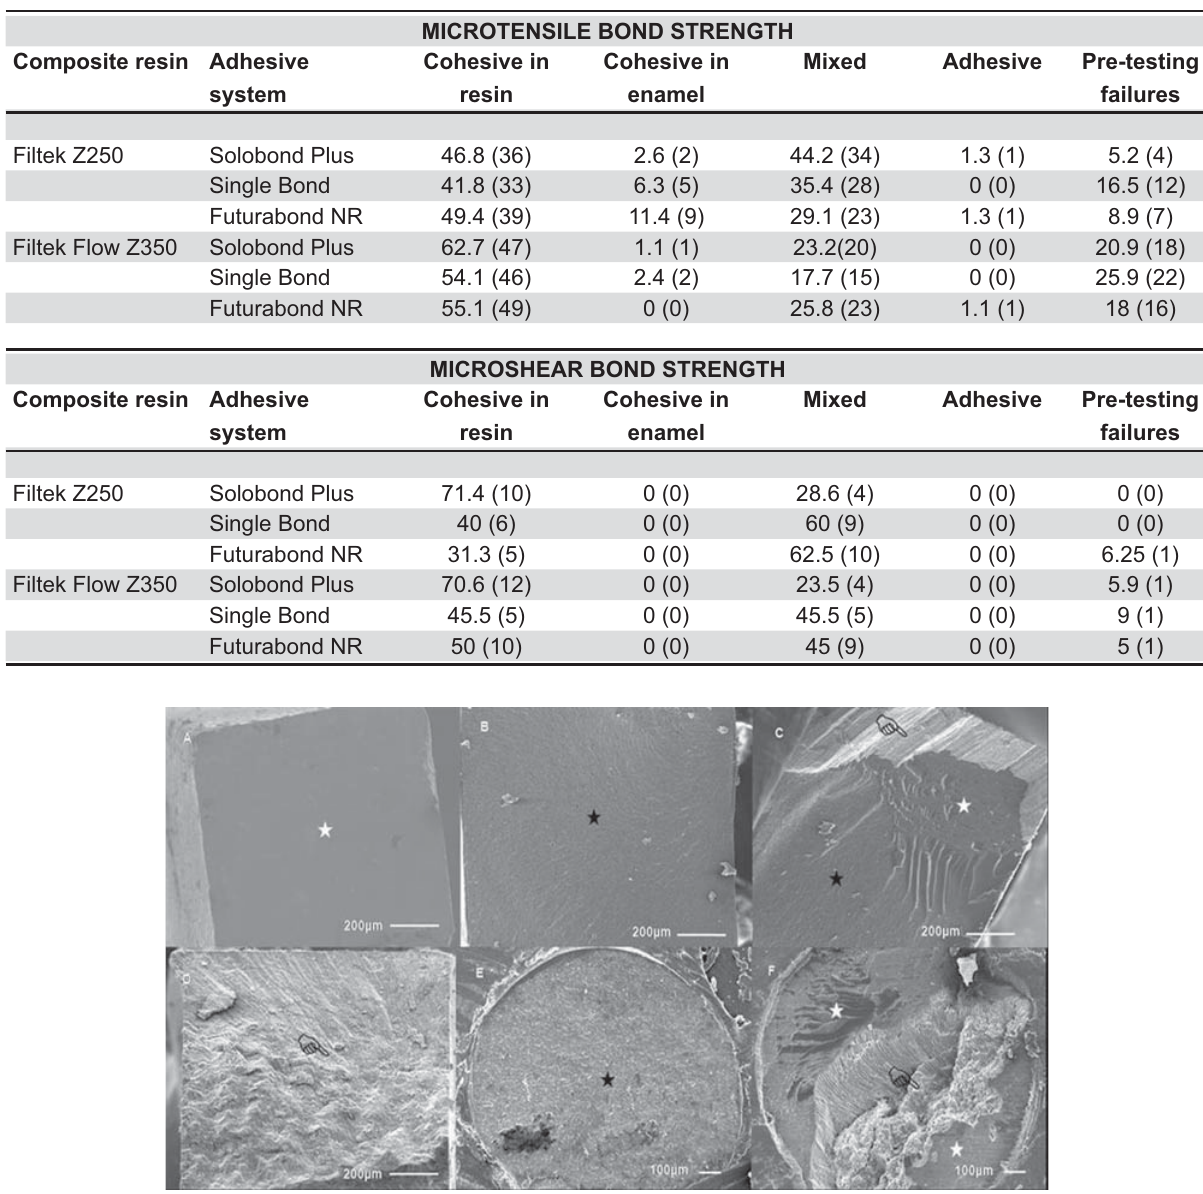
half was paired (total of 36 means) and the values were tested by the Pearson correlation test at (cid:3) (cid:2)(cid:3)(cid:4)(cid:3)(cid:5)(cid:4)(cid:7)(cid:130)(cid:22)(cid:7)(cid:13)(cid:16)(cid:9)(cid:7)(cid:10)(cid:9)(cid:17)(cid:18)(cid:22)#(cid:7)(cid:20)(cid:29)(cid:29)(cid:19)(cid:18)(cid:20)(cid:17)(cid:16)(cid:7)(cid:18)(cid:22)(cid:12)(cid:26)(cid:7)(cid:13)(cid:16)(cid:9)(cid:7)(cid:18)$(cid:9)(cid:19)(cid:20)(cid:12)(cid:12)(cid:7)